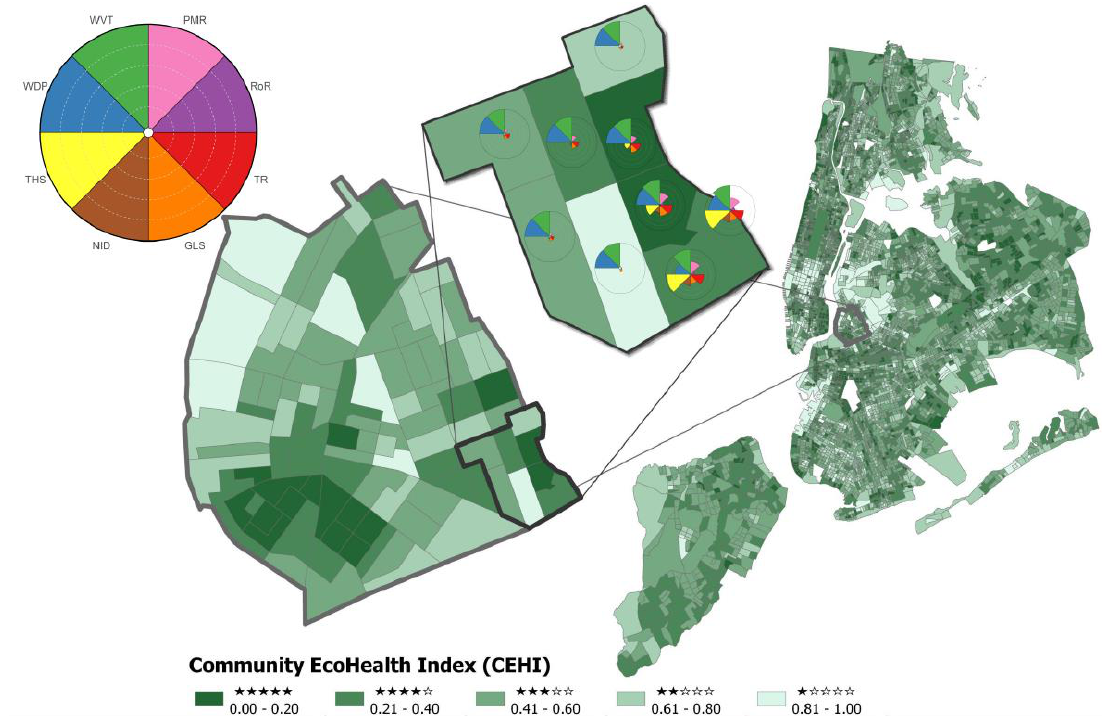
Figure 6. CEHI IndW rankings for New York City, NY area (NYNY) are shown (right). Rose plots of individual metrics (center), normalized based on values within NYNY, are shown for CBGs in the Williamsburg neighborhood (left) of Brooklyn, NY.